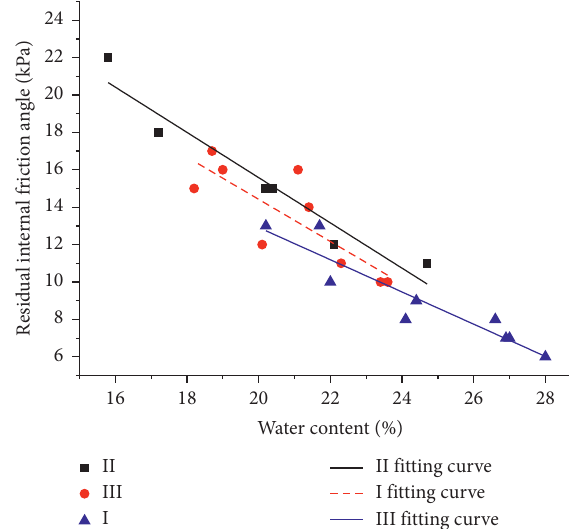
Figure 15: The curve of residual internal friction angle with moisture content